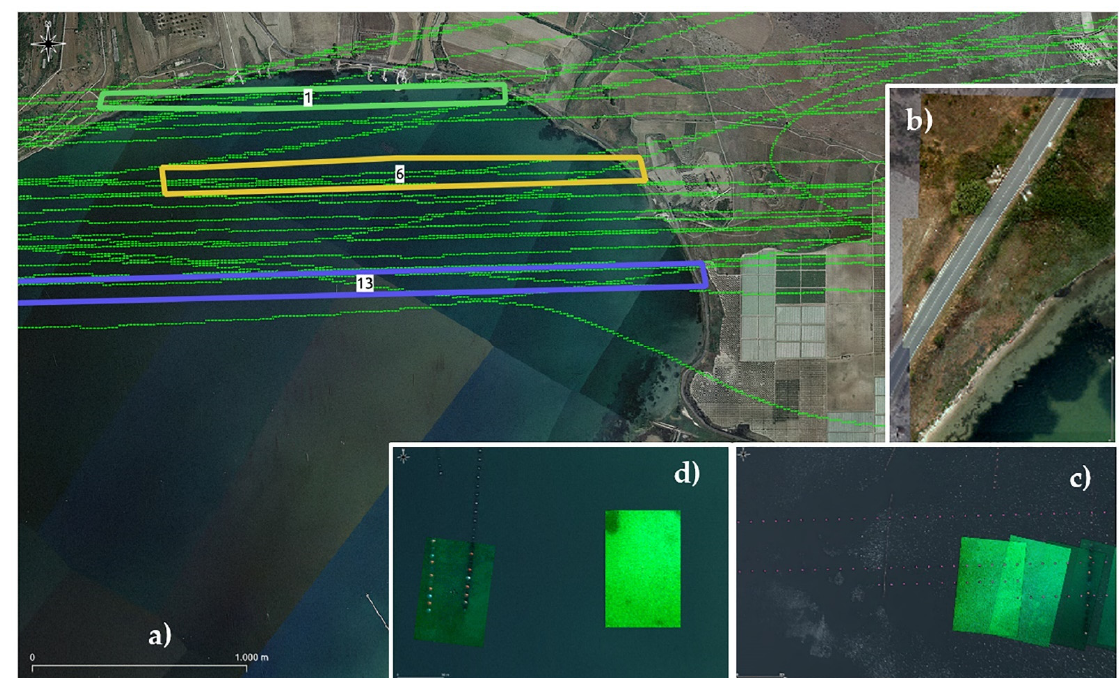
Figure 9. ( a ) phase of the creation of the union framework. Detail of some video tracks during processing, a detail in which the set of significant individual frames is superimposed for each flight path. ( b ) Mosaic of two frames of the investigated study area. The perfect overlap of them is shown with the example of a street; ( c ) Overlapping of the frames after the georeferencing phase with the flight route data identified with dots; ( d ) Example of how a frame, not affected by the presence of anthropogenic objects, is coloured (right).